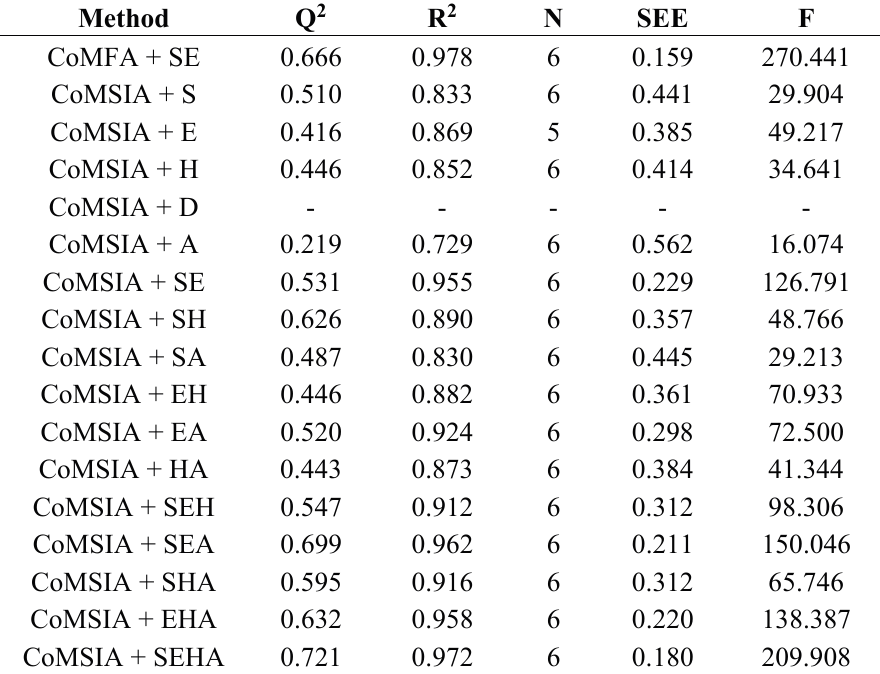
Figure 2. Molecular alignment based on atom root mean square (RMS) was used in the 3D-QSAR studies. Table 2. Summary of validation statistics for CoMFA and CoMSIA Models generated based on the